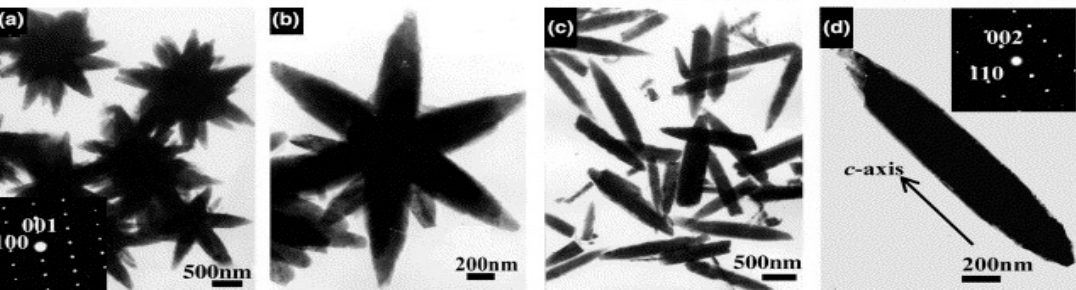
Figure 2. TEM micrographs: ( a , b ) Flowerlike ZnO; ( c , d ) needlelike ZnO [51]. Copyright Elsevier, 2004.